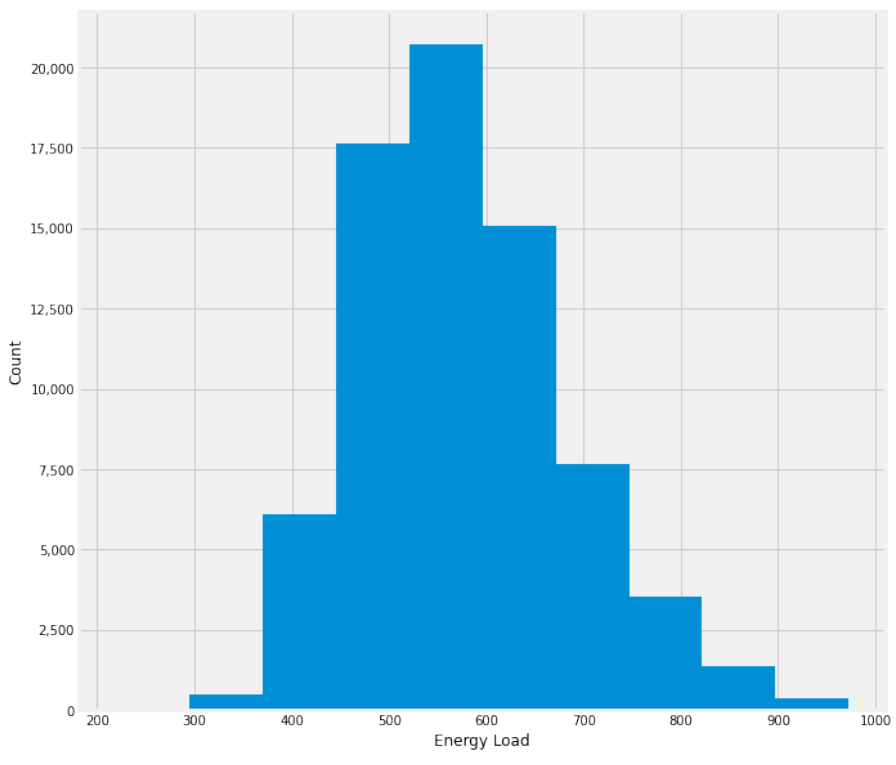
Figure 8. Distribution of variable load.